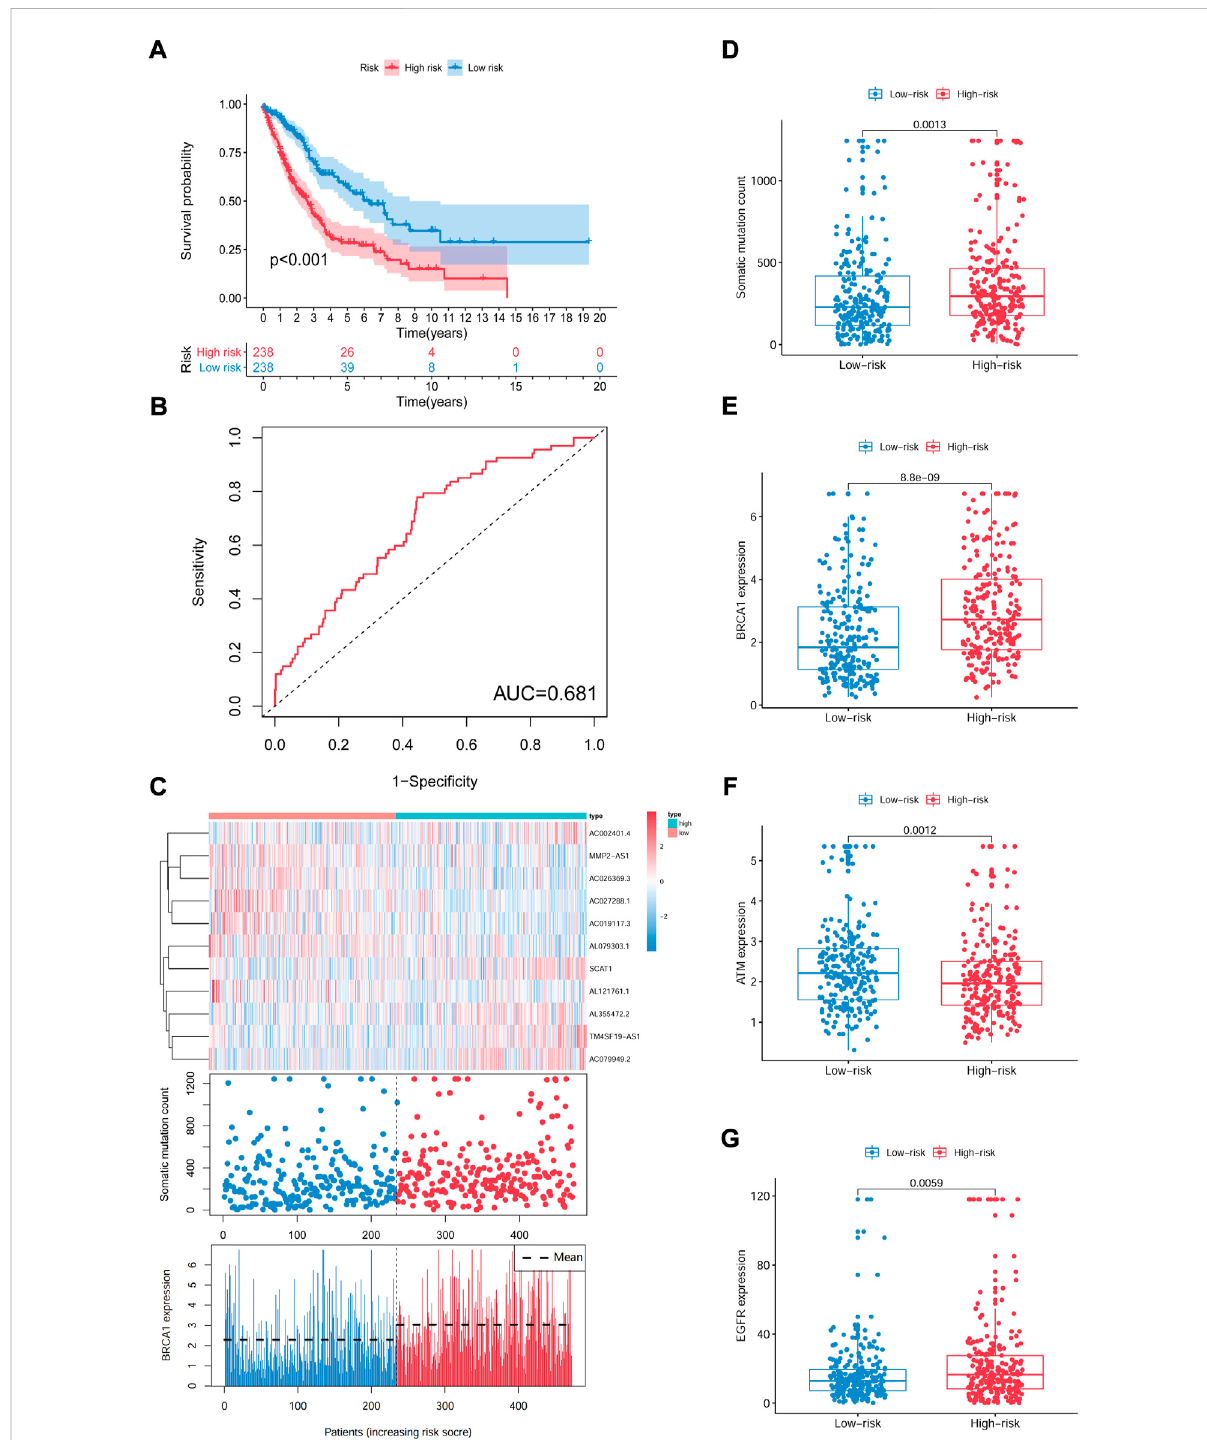
FIGURE 5 Identi fi cationoftheGIrLncSigthatpredictsoutcomeinthetrainset. (A) Kaplan-MeierestimatesofOSfor patientspredictedbyGIrLncSiginthe train set. (B) ROC curves analysis of GIrLncSig over time. (C) LncRNA expression patterns, somatic mutation count and BRCA1 expression in two groups. (D) Somatic mutationcount intwo groups. (E) (F) (G) Expression of BRAC1, ATM, and EGFR in two groups. Red stands for thehigh-risk group and blue for the low-risk group. GIrLncRNAs, genomic instability-related lncRNAs signature; ROC, receiver operating